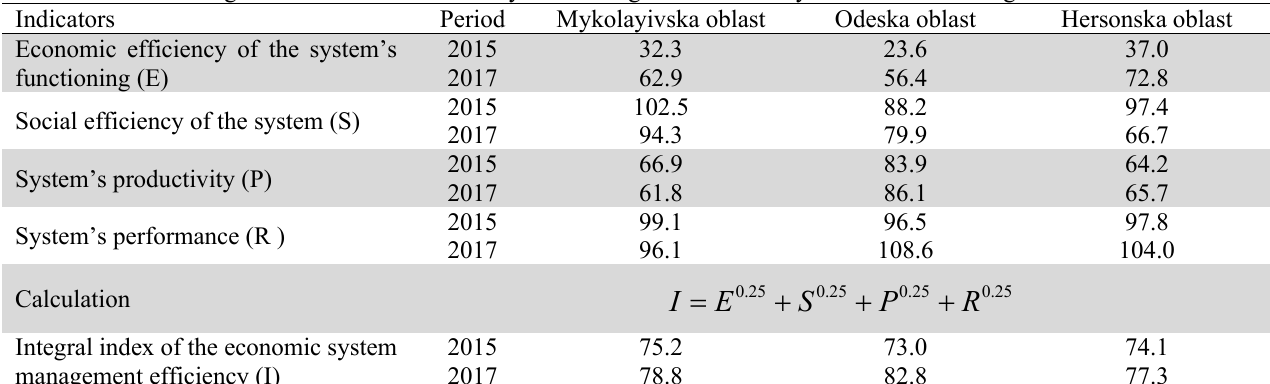
Calculation of the integral index of the economic system management efficiency in the Black Sea region of Ukraine Indicators Period Mykolayivska oblast Odeska oblast Economic efficiency of the